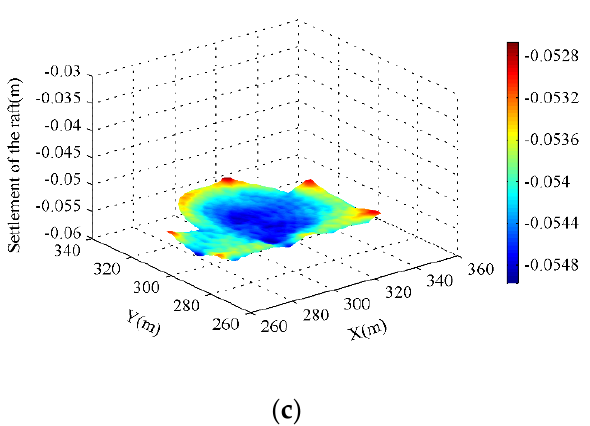
Figure 12. Raft settlements of the three cases after optimization design: ( a ) C1-94-O; ( b ) C2-97-O; ( c ) C3-173-O. Table 7. Comparison of settlements of the rafts and pile top stress for different cases after AOM-ES. Model